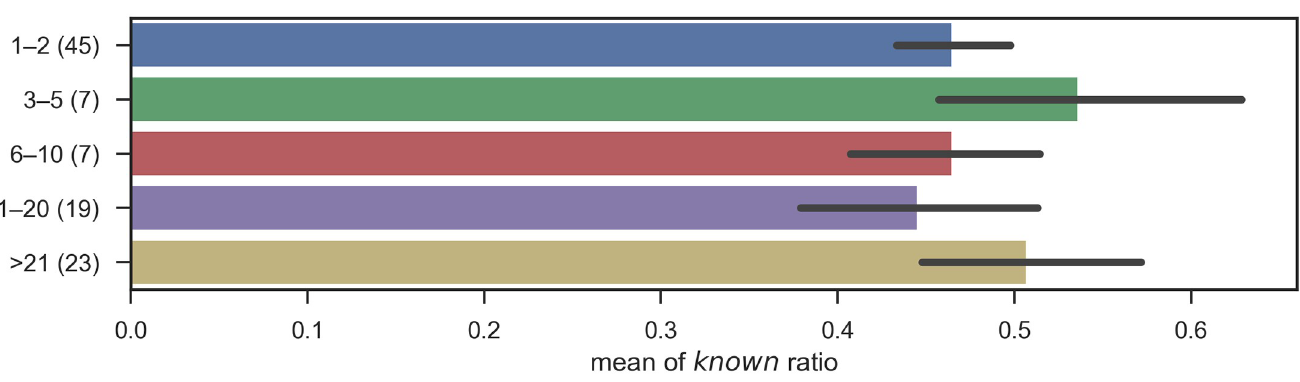
Fig 4. Known ratio, grouped by years of post-graduate experience: The error bars shows the standard errors.